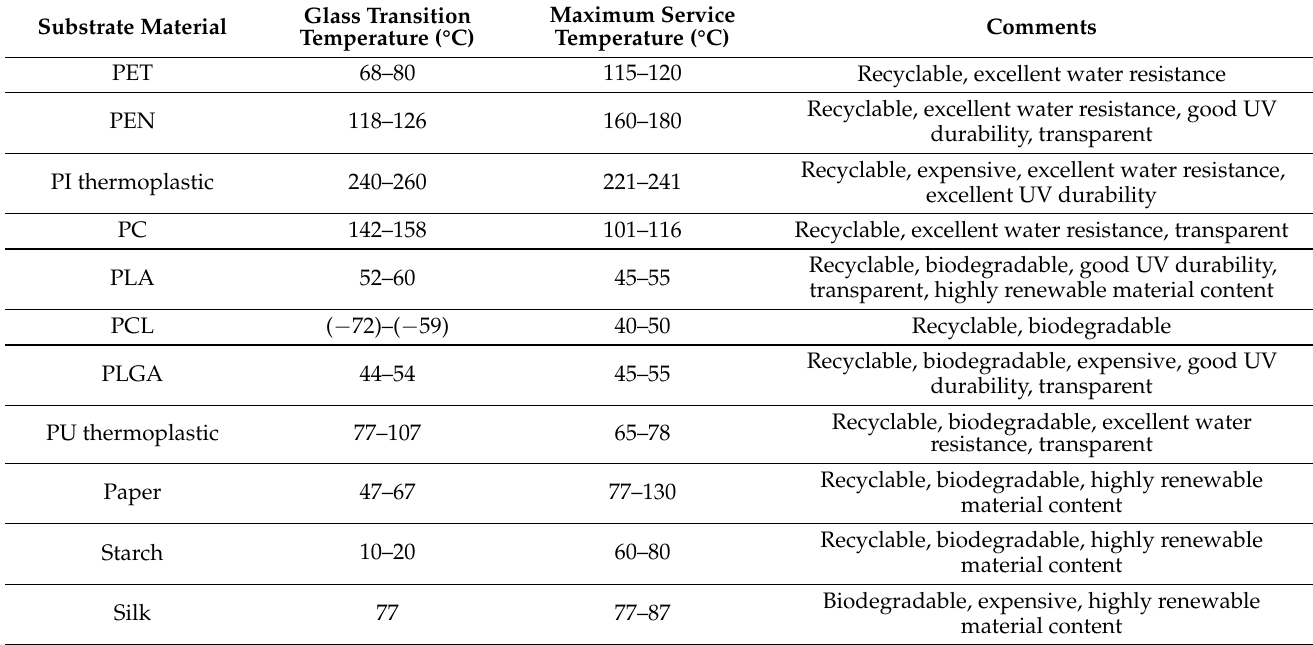
Table 3. Glass transition temperature, maximum service temperature and authors’ comments about different recyclable and biodegradable substrate materials. Here, the maximum service temperature refers to the highest temperature where the material can be used for an extended period of time without notable problems